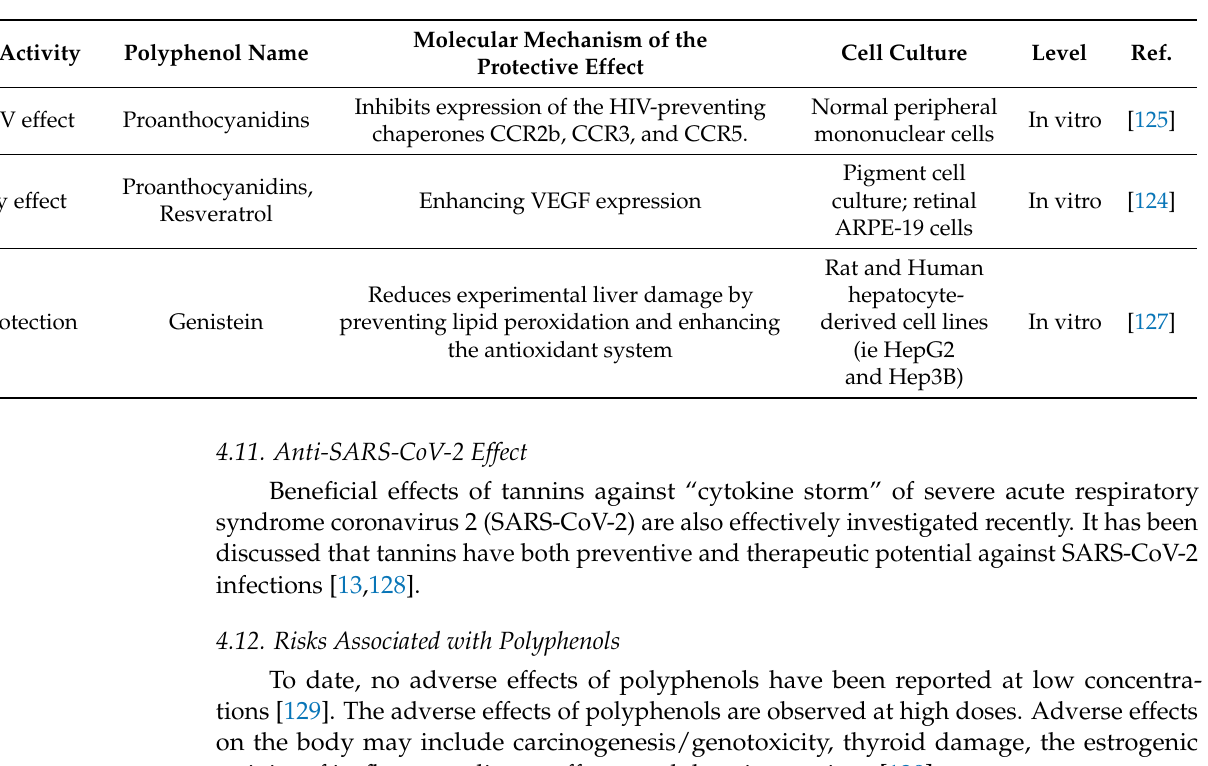
Table 14. Other bioactive effects of the polyphenol content of grape marc (grape seeds and